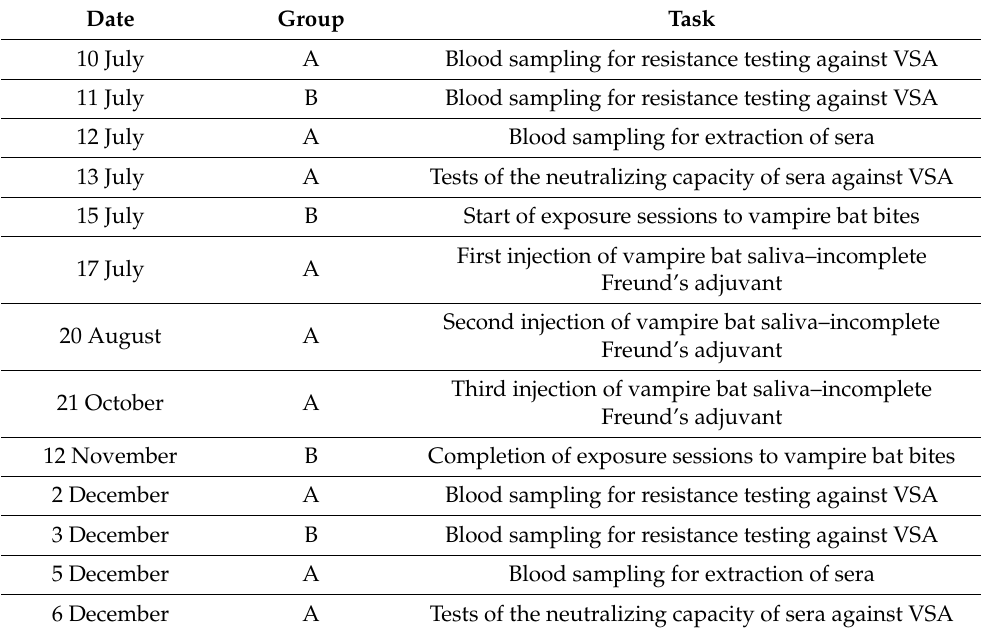
Table 1. Tasks performed during the study in experimental sheep. Groups: A (injected with vampire bat saliva) and B (exposed to vampire bat